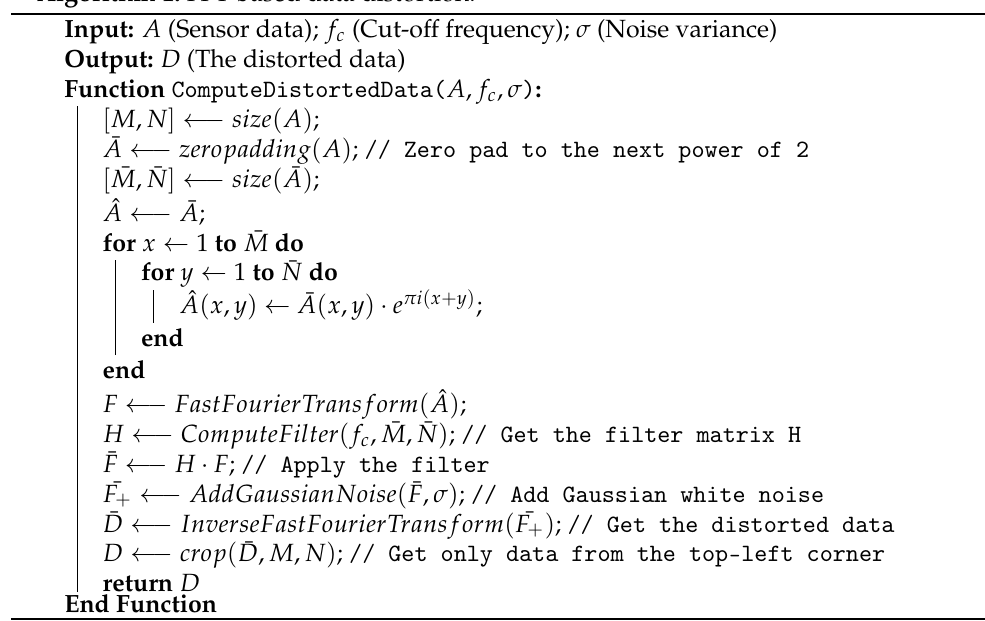
Algorithm 1: FFT-based data